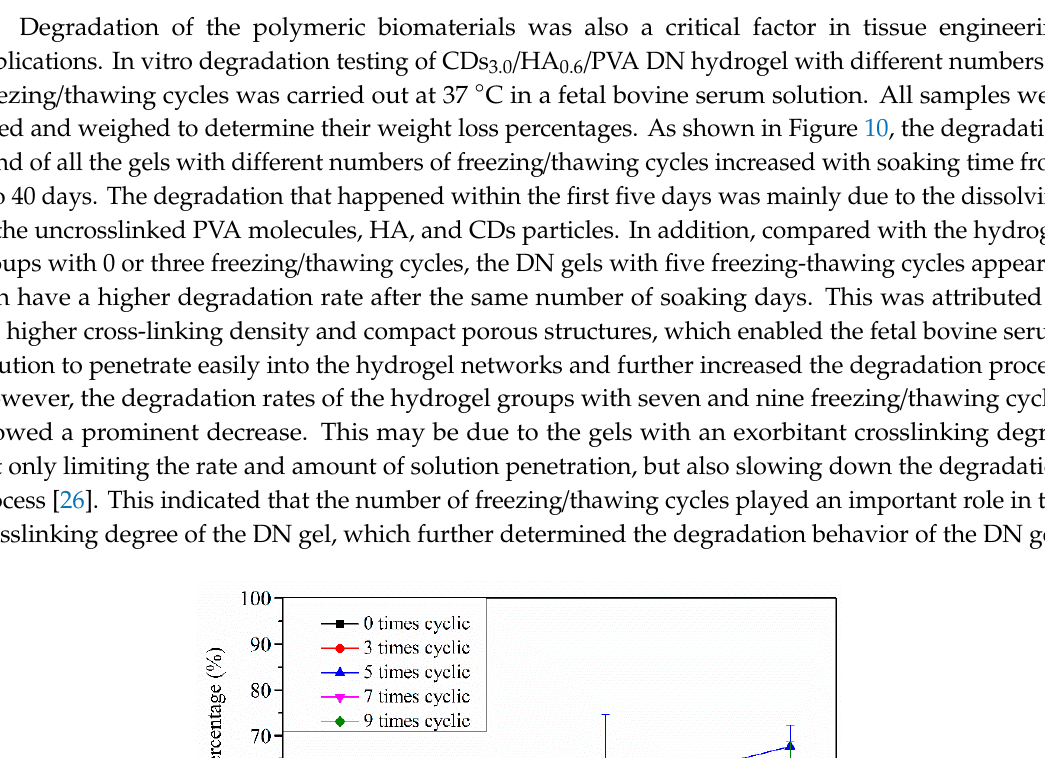
Figure 9. The swelling ratios of ( a ) the CDs/HA/PVA DN hydrogels with mass ratios of CDs to PVA at 0%, 1.5%, and 6.0% and ( b ) CDs 3.0 /HA 0.6 /PVA DN hydrogels with 0, 3, 5, 7, and 9freezing/thawing cycles, respectively.